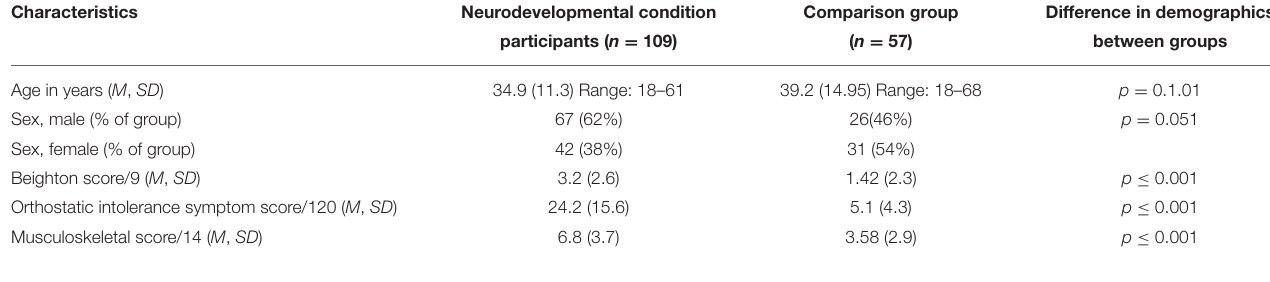
TABLE 1 | Group characteristics.